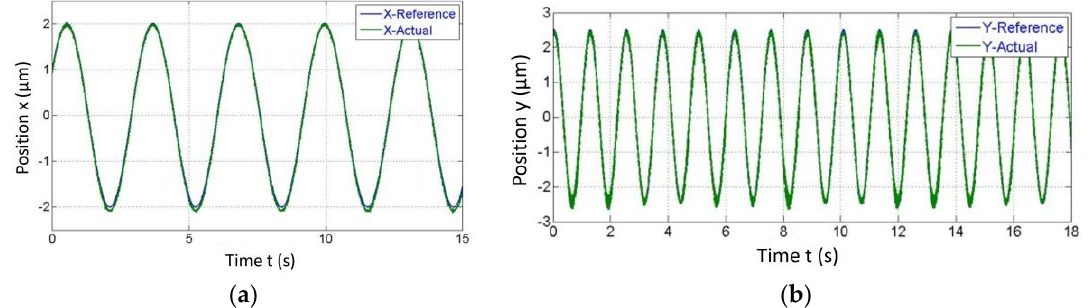
Figure 23. Separate outputs from the algorithm in each the ( a ) X and ( b ) Y direction for tracking a zigzag path.